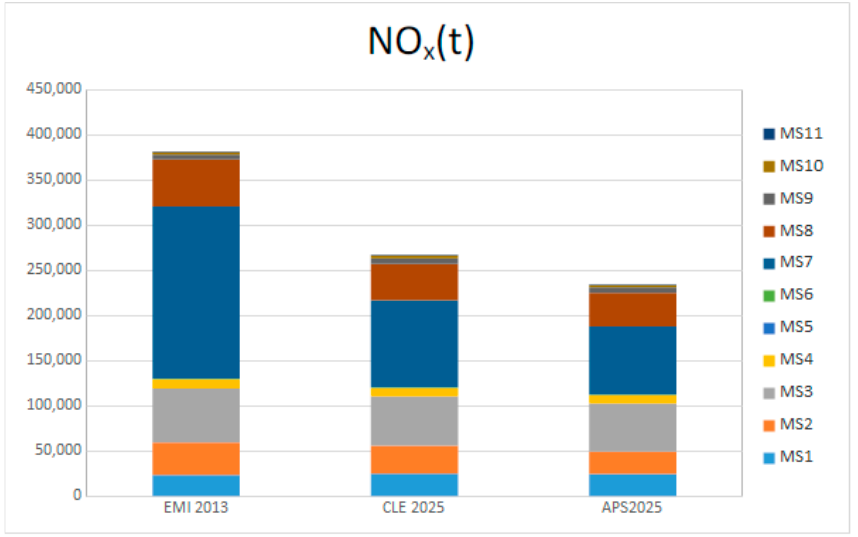
Figure 2. Emission scenarios for